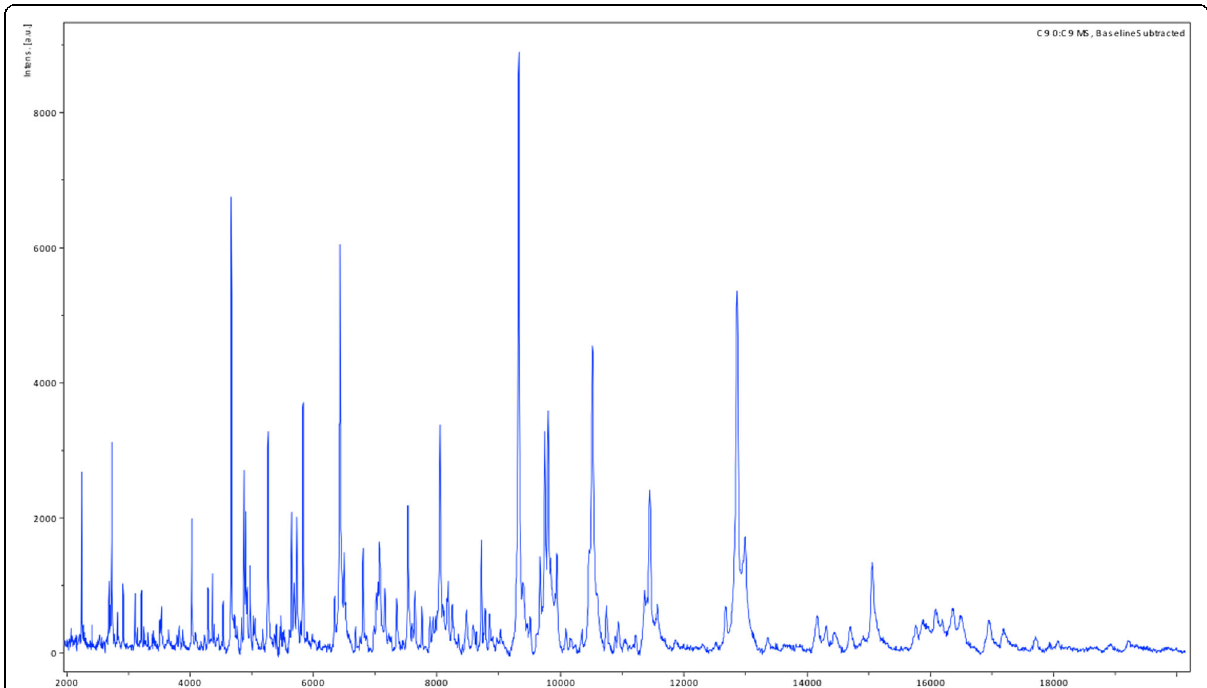
Fig. 1 Reference mass spectrum from Fermentimonas caenicola SIT8. This reference spectrum was generated by comparison of 12 individual colonies